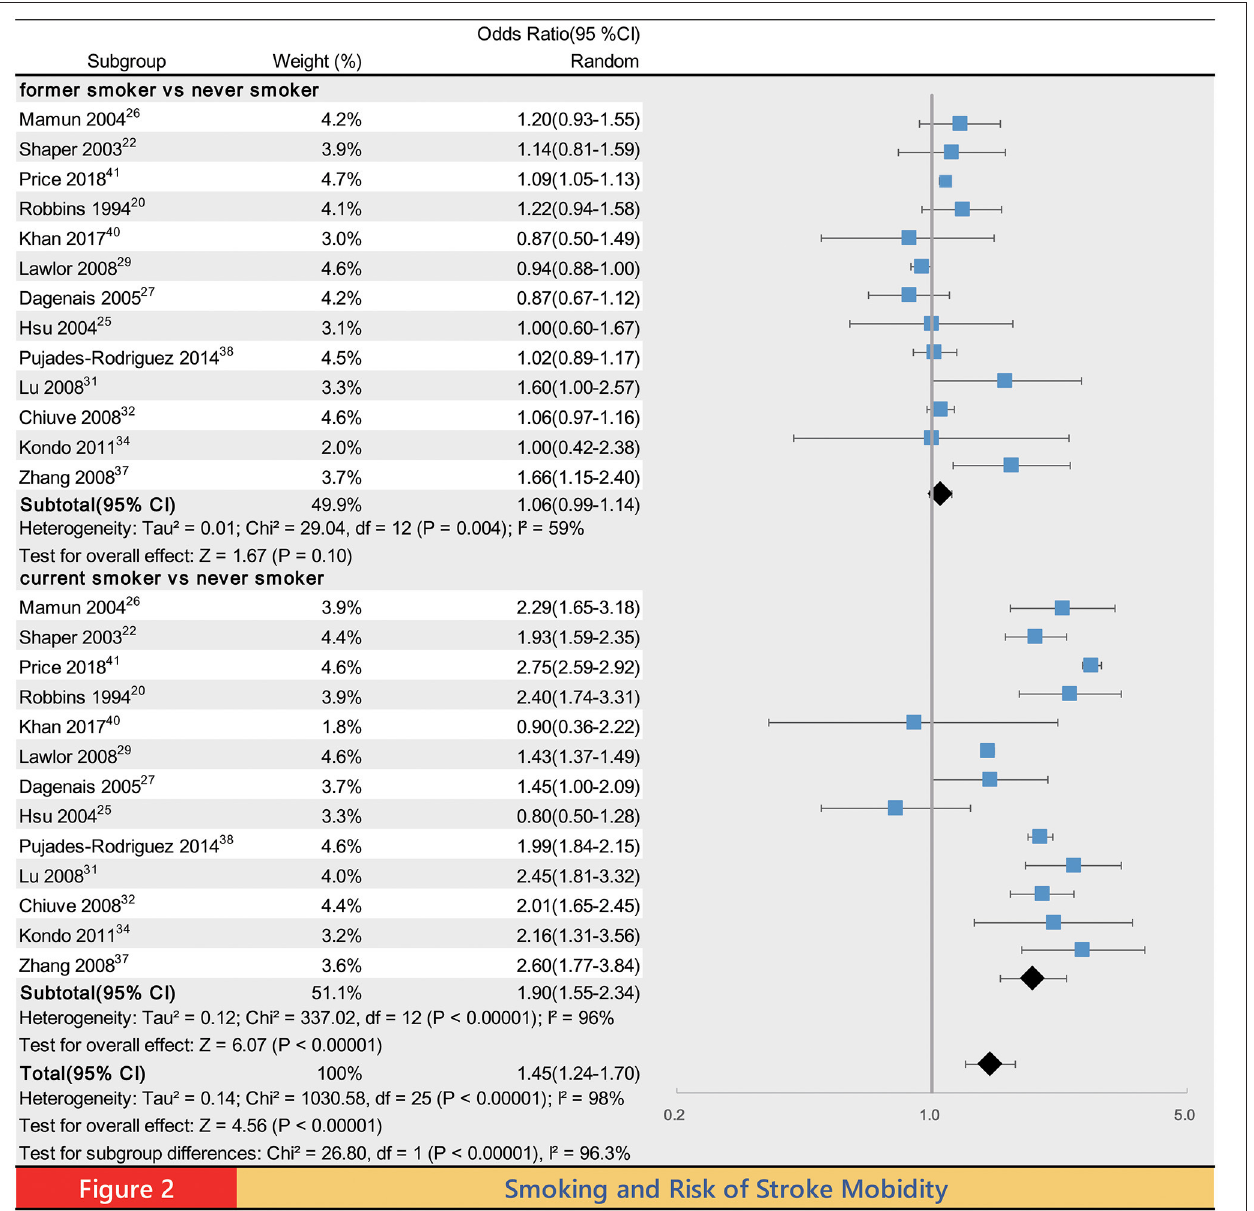
a dose-response relationship between CPD and duration of cessation and risk of different pathologic types of